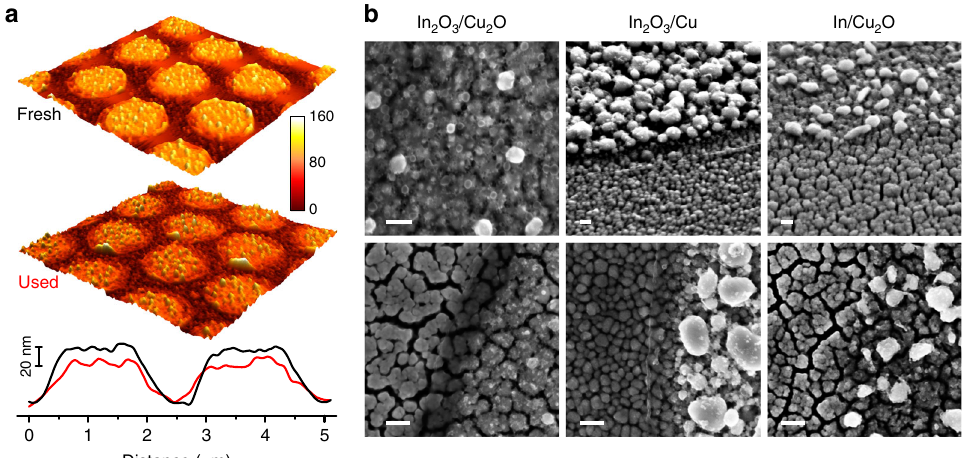
Fig. 4 Microscopy of structured electrodes after the catalytic testing. a Pre- and post-reaction AFM analysis over a representative In 2 O 3 /Cu 2 O electrode ( d = 1.25 μ m) and corresponding pro fi les across two adjacent islands. Analysed area ca. 7.2 μ m × 7.2 μ m. The colour scale is associated to nanometres. b Representative post-reaction SEM micrographs for different Cu-In compositions. The interior of the islands is distinguishable by the presence of white particles. The top left image shows the centre of and island. Scale bars: 100 nm